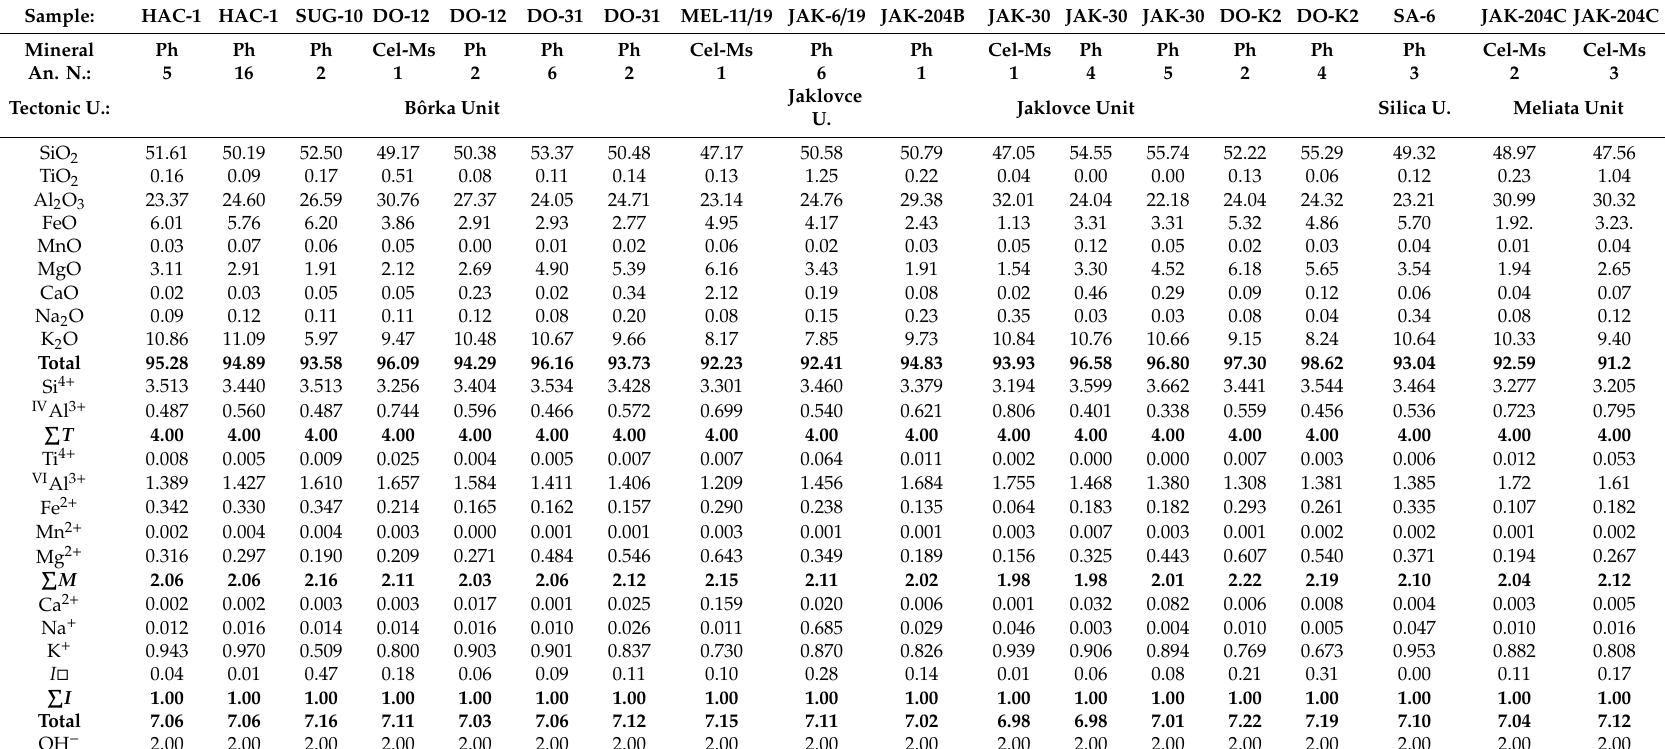
Table 4. Representative analyses of white mica from the B ô rka, Jaklovce, Meliata and Silica